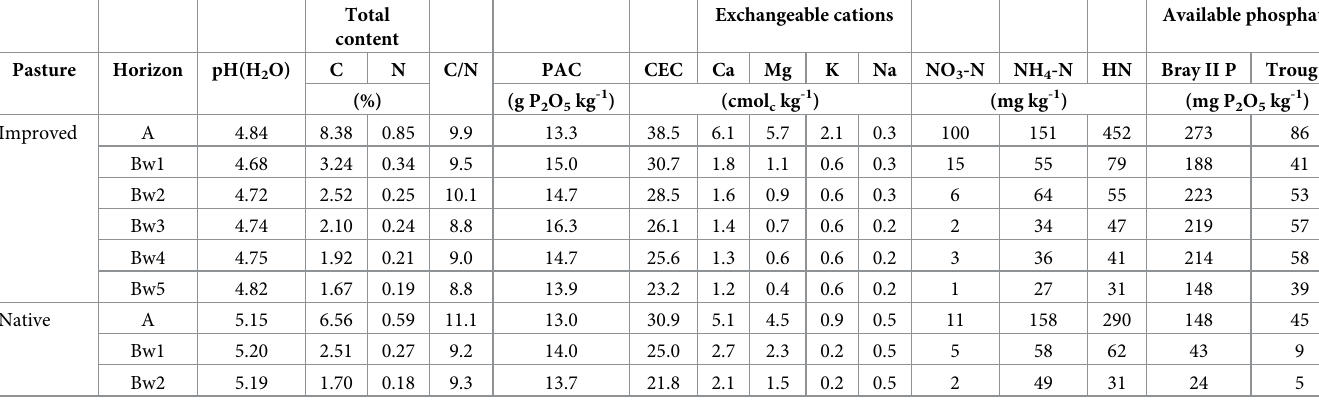
Table 3. Soil chemical properties of horizons in the two pastures in 2019.